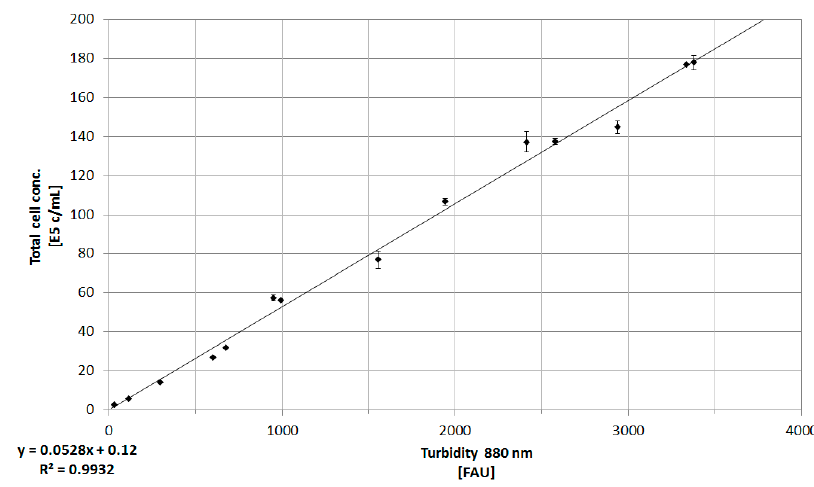
Figure 5. Correlation between offline determination of total cell concentration (E5 cells/mL) and online turbidity measurements (880 nm, FAU). Error bars represent the double determination of cell concentration, as well as the error of the probe (0.75%). The coefficient of determination for this linear relation is >0.99.